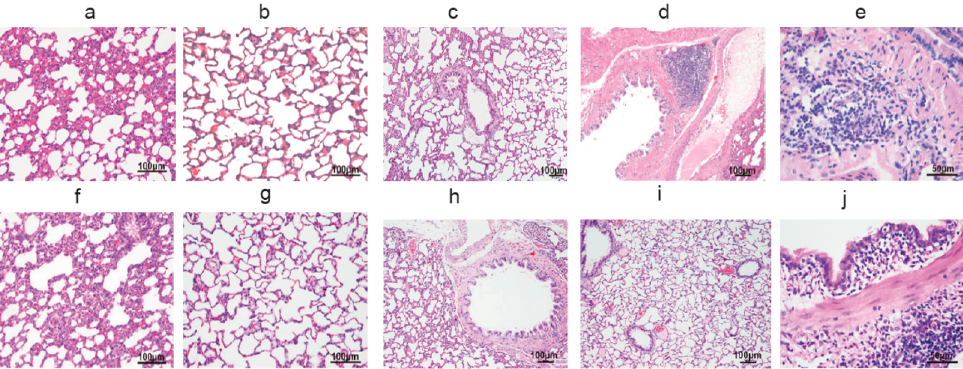
Figure 1. Lung histology (HE stain) of pregnant rats and 8-week-old male pups. ( a ) The alveolus of a pregnant rat exposed to unfiltered air; ( b ) the alveolus of a pregnant rat exposed to filtered air; ( c ) the bronchus of an unfiltered air exposed pregnant rat; ( d ) the bronchus of a filtered air exposed pregnant rat; ( e ) the mononuclear inflammatory infiltrates of an unfiltered air exposed pregnant rat; ( f ) The alveolus of 8-week-old rats exposed to unfiltered air; ( g ) the alveolus of 8-week-old male pups exposed to filtered air; ( h ) the bronchus of an unfiltered air exposed 8-week-old male pup; ( i ) the bronchus of an filtered air exposed 8-week-old male pup; ( j ) the mononuclear inflammatory infiltrates of an unfiltered air exposed 8-week-old male pup.